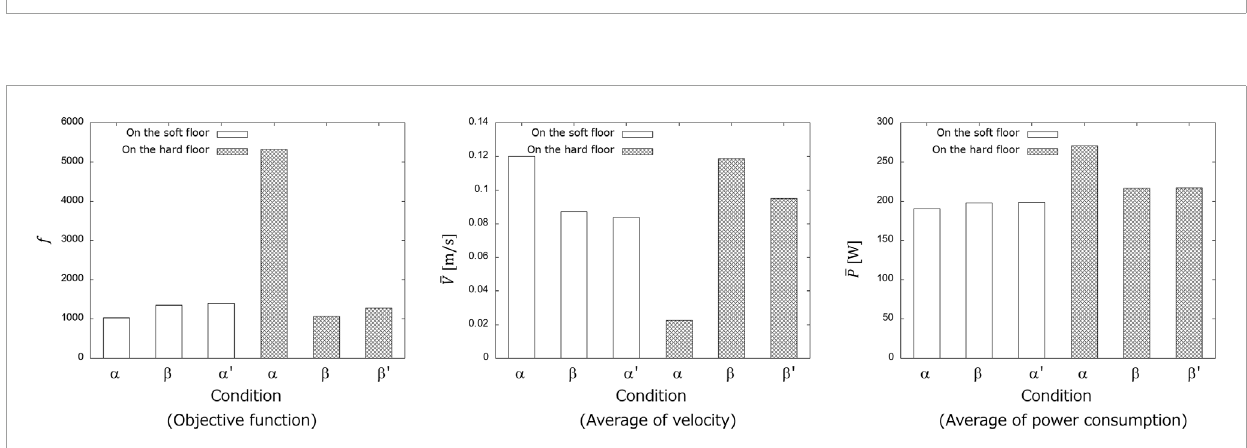
FIGURE 13 Propulsion behavior on the hard floor with parameters obtained under the hard floor condition.